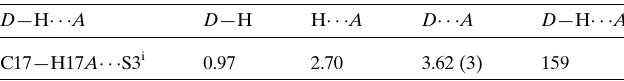
Table 1 Hydrogen-bond geometry (A˚ , (cid:4) ).